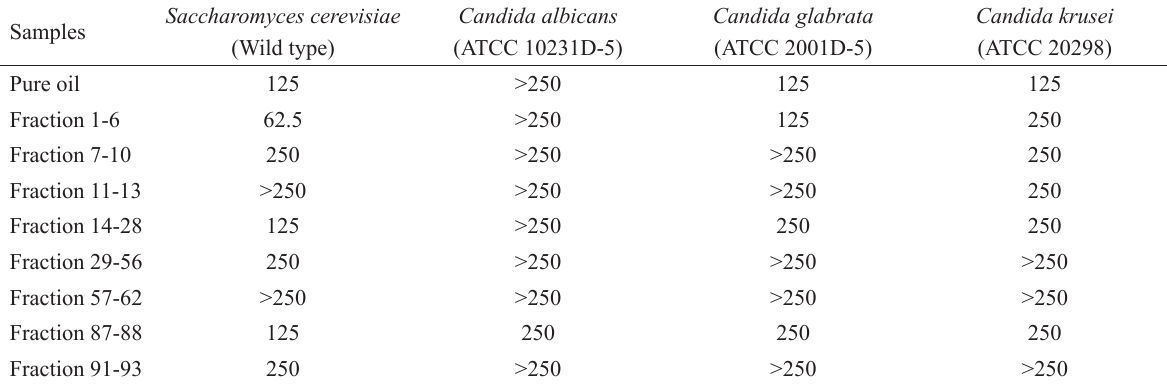
Antifungal activities of the essential oil and its fractions from fresh leaves of Casearia sylvestris (MIC